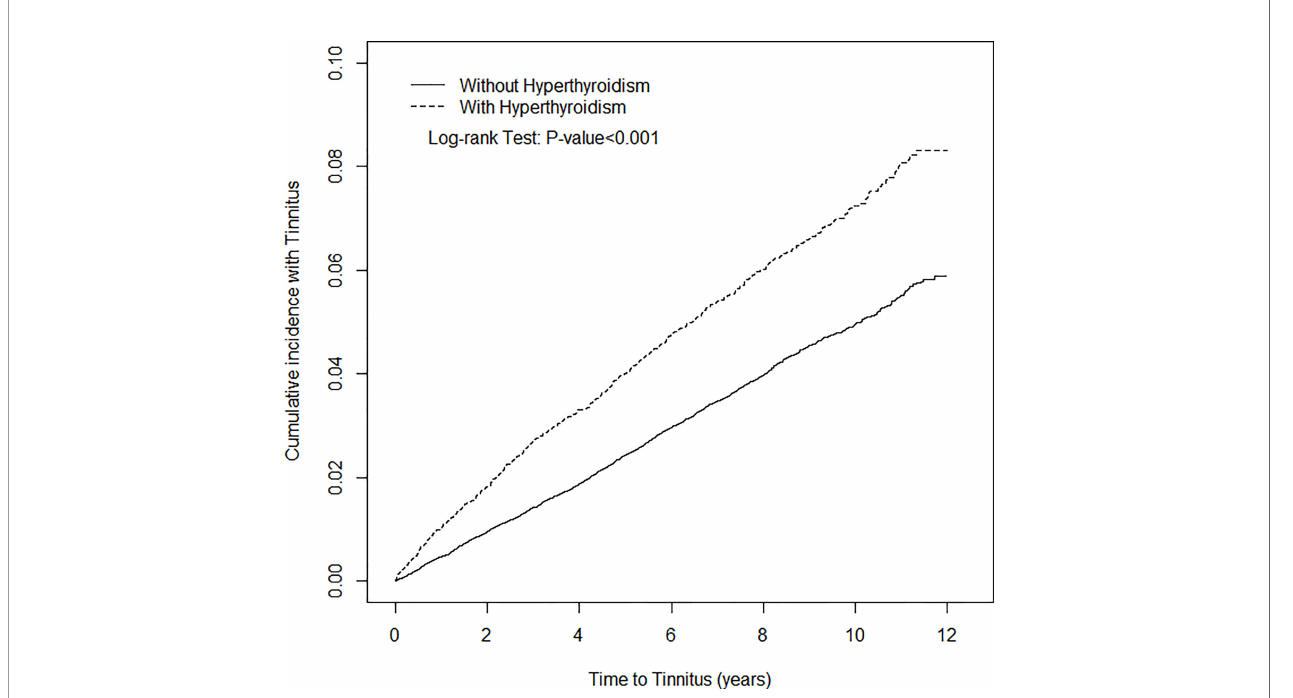
FIGURE 1 | Cumulative incidence of Tinnitus for patients with (dotted line) or without (solid line)